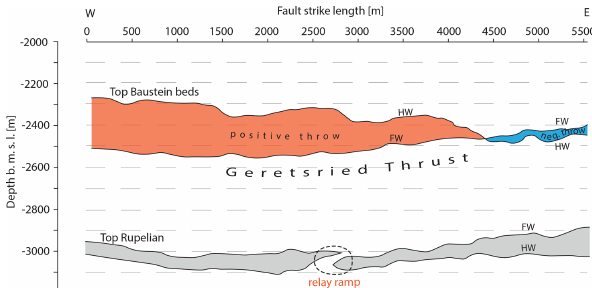
Figure 9. Alan map of the Geretsried Thrust at top Baustein beds (red for “positive” throw and blue for “negative” throw) and of the underlying normal faults at top Rupelian (grey). Note substantial decrease of throw on the Geretsried Lower Thrust to the E. See text for discussion. Footwall and hanging-wall cut-offs are abbreviated FW and HW,